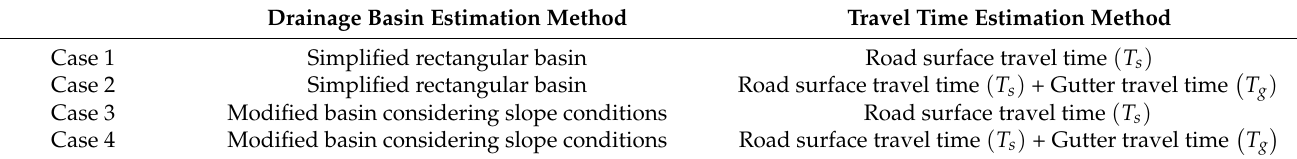
Table 4. Experimental conditions for the road surface-runoff